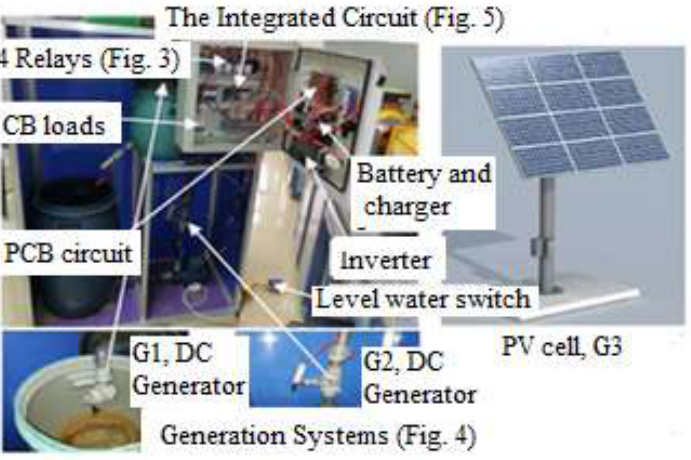
Figure 13. The practical integrated model of the hybrid generation system.